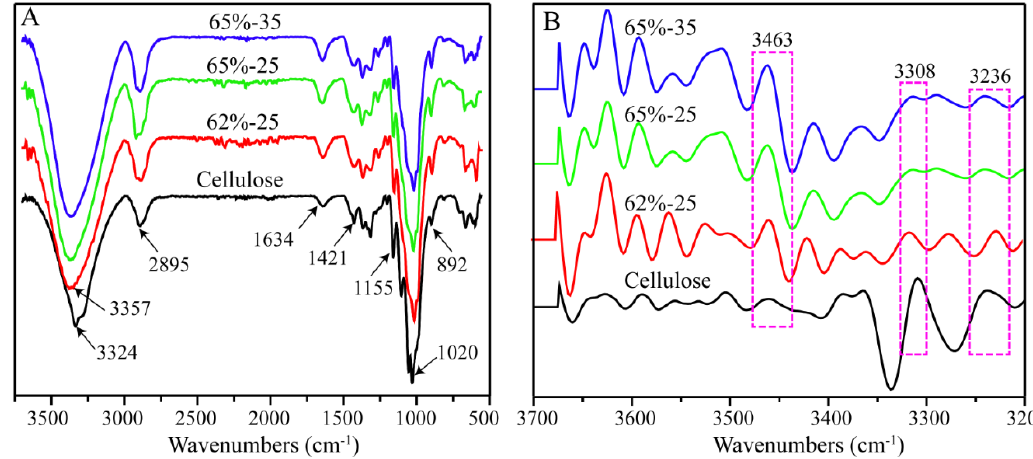
Figure 1. Fourier transform infrared (FT-IR) spectra ( A ) and relative second-derivative FT-IR spectra ( B ) of cellulose samples. ( B ) of cellulose